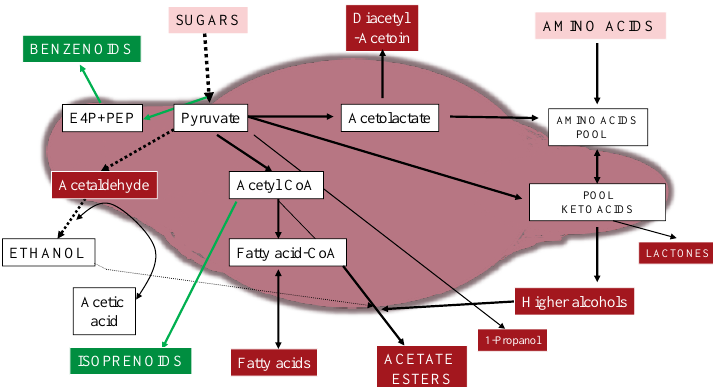
Figure 4. Fermentation flavor compounds produced by Hanseniaspora / Kloeckera yeasts during wine production (red and green boxes). Specific metabolic pathways that are highlighted in some species of this genus are shown in green (arrows and boxes). Pink boxes are the medium nutrients and doted arrows showed the main glycolysis pathway of primary fermentation.